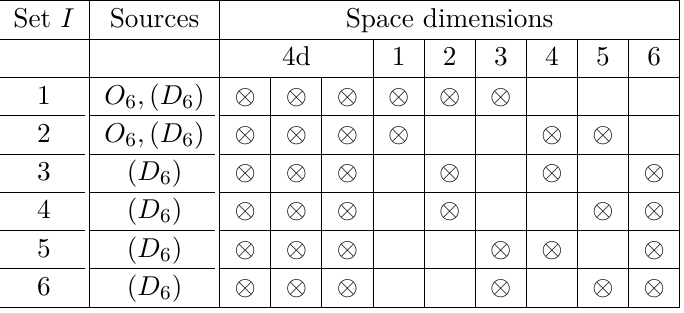
Table 7 . O 6 /D 6 source configuration in the class s 66 . Sources in parentheses are not